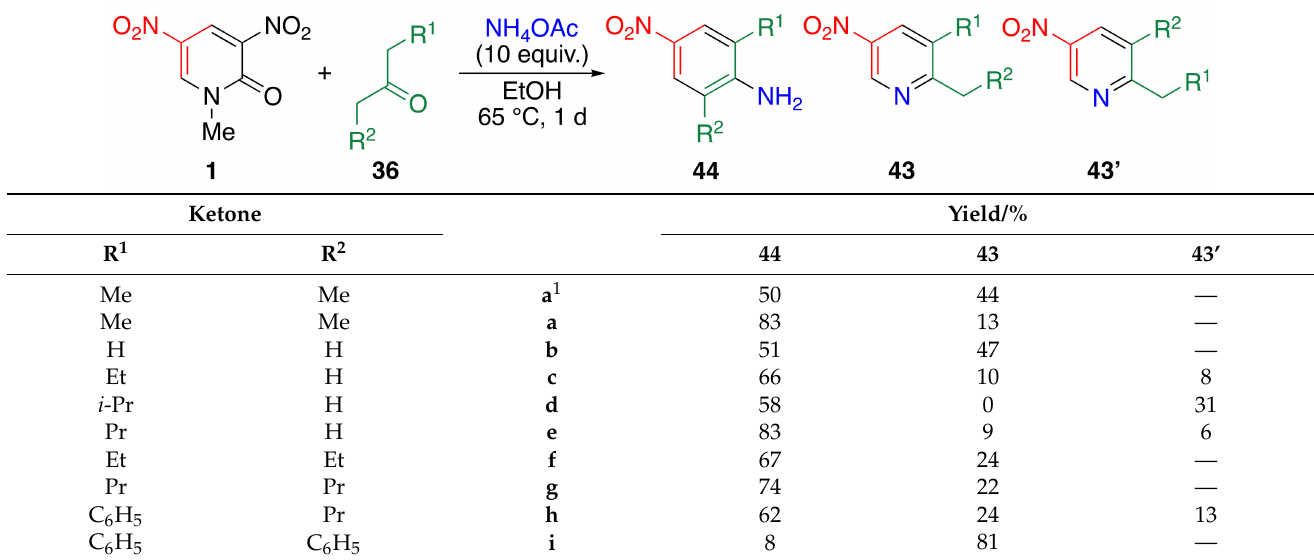
Table 9. Two kinds of TCRT using aliphatic ketones 36